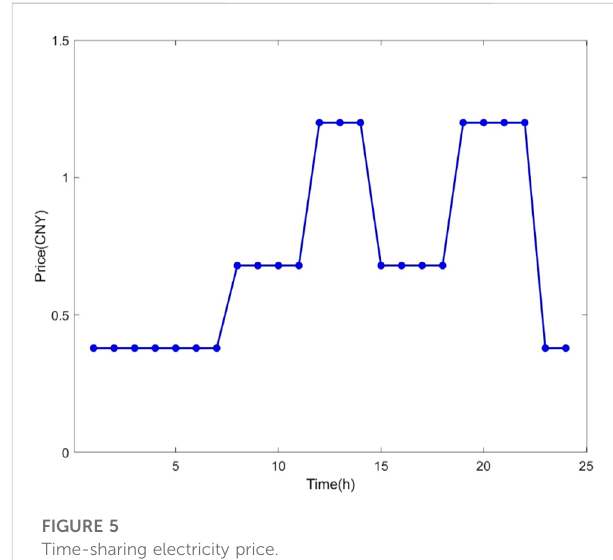
FIGURE 5 Time-sharing electricity